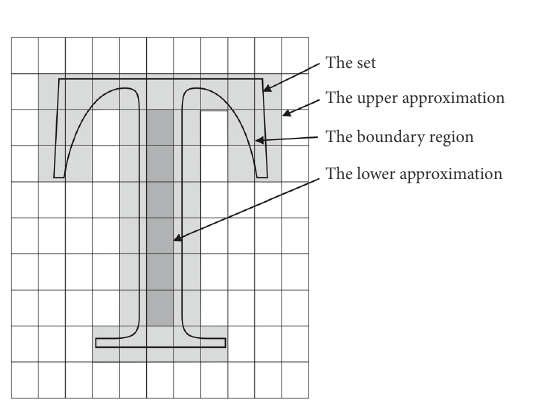
Figure 2. Rough set